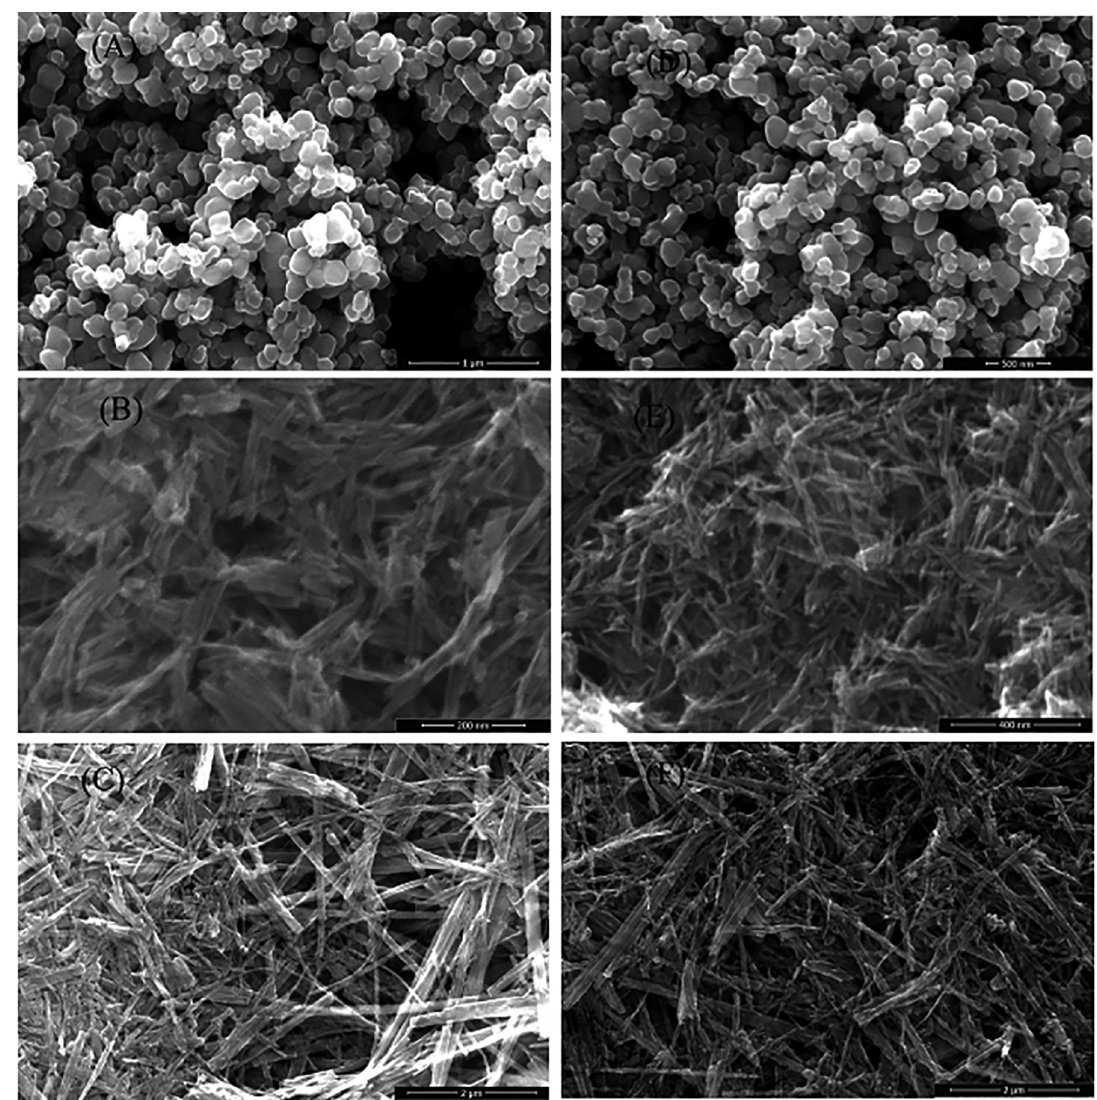
; (B) NaTiNT; (C) Nanoribbons and (D) TiO 2